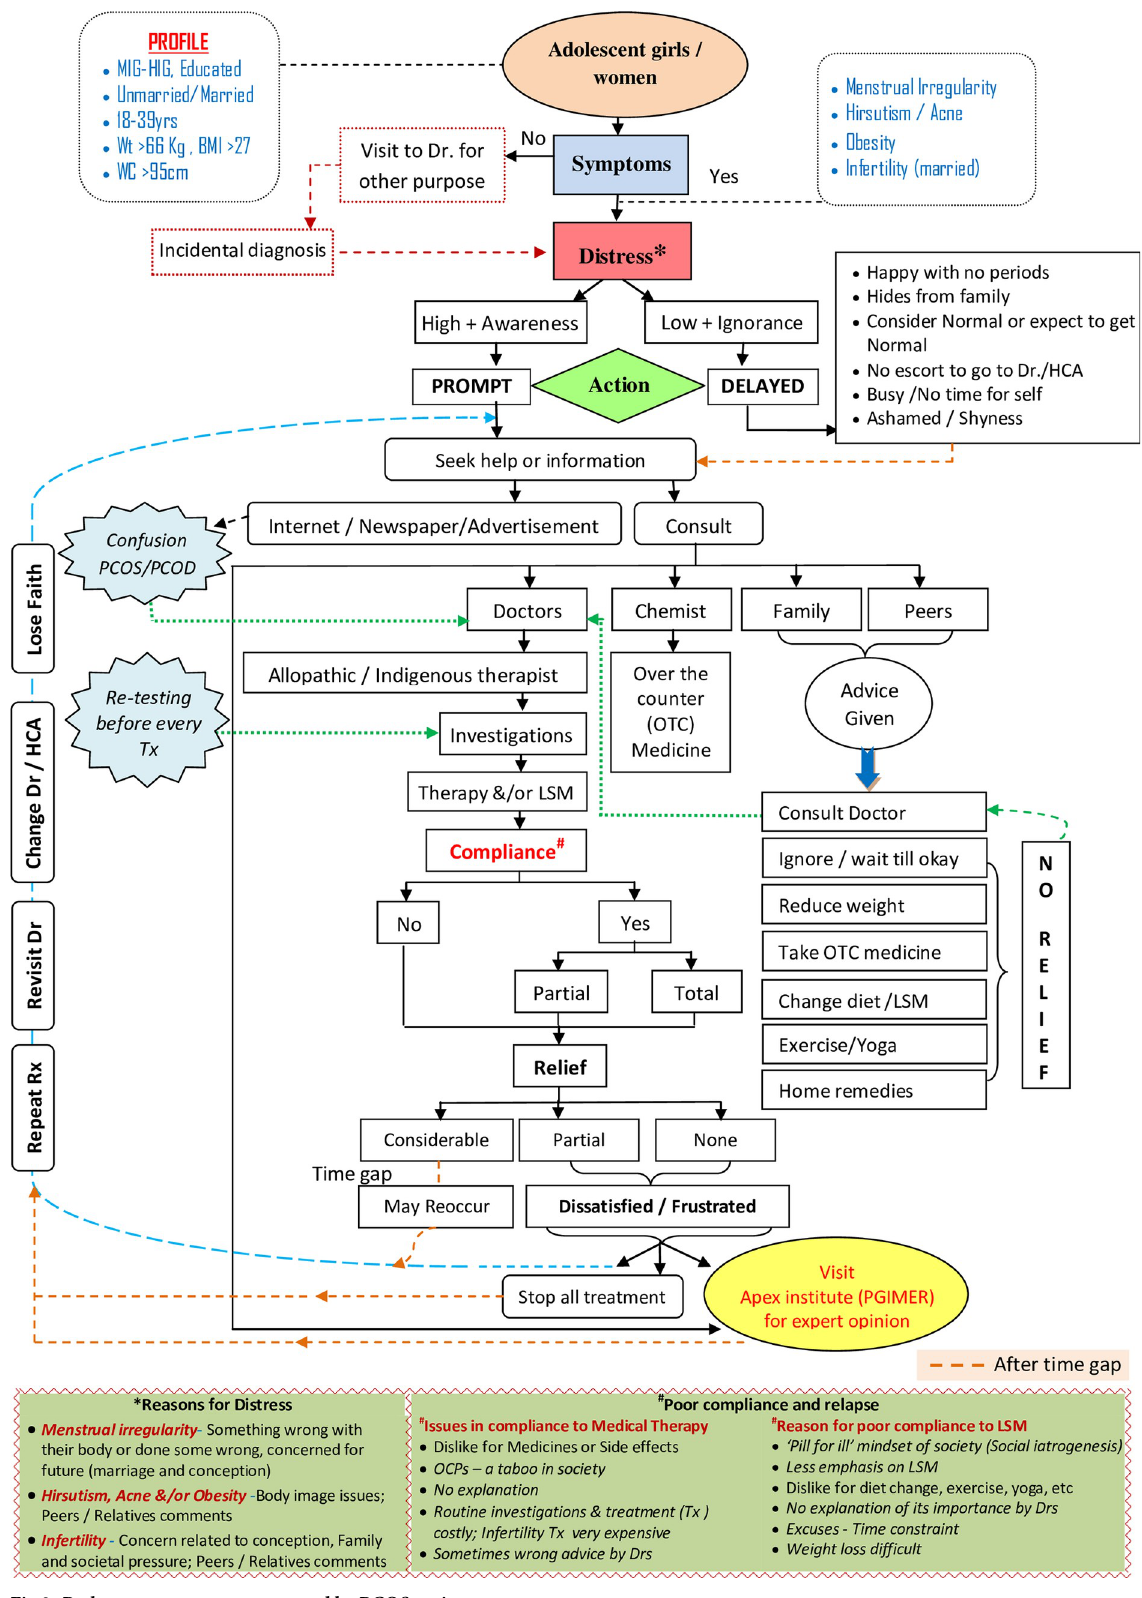
Fig 3. Pathways to treatment traversed by PCOS patients. https://doi.org/10.1371/journal.pone.0255830.g003 PLOS ONE | https://doi.org/10.1371/journal.pone.0255830 August 9,